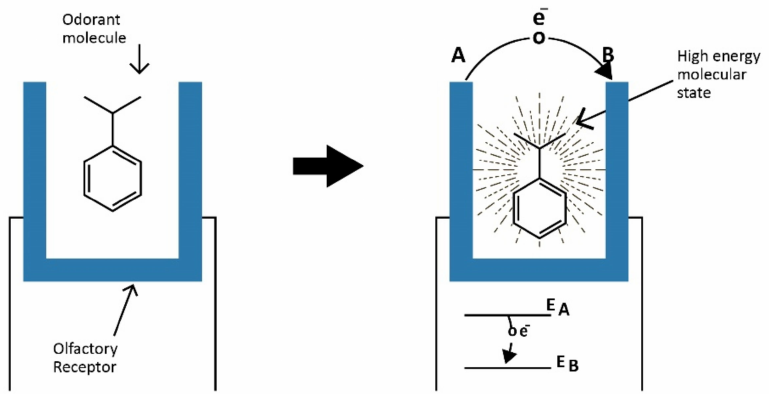
Figure 2. The inelastic electron tunneling mechanism is illustrated for human olfaction. When an odorant molecule binds in the receptor ( left ), an electron transition from a high energy state A to a lower energy state B occurs with the difference in energy creating a high energy molecular state of the odorant molecule ( right